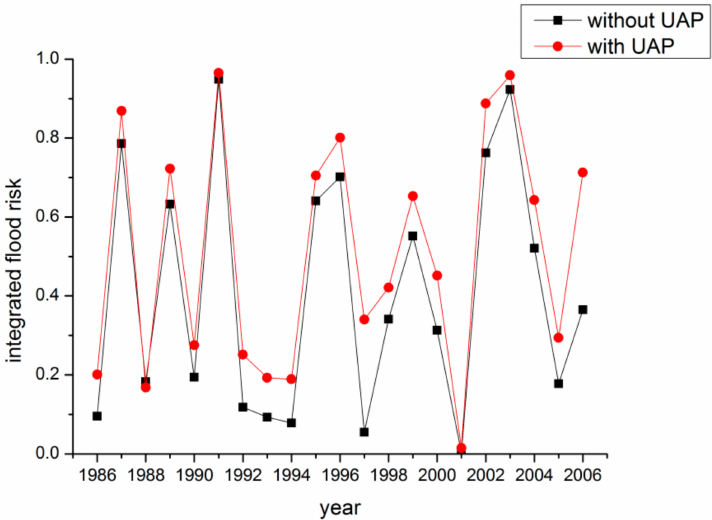
Figure 7. The exceedance probability curve of individual flood variables.